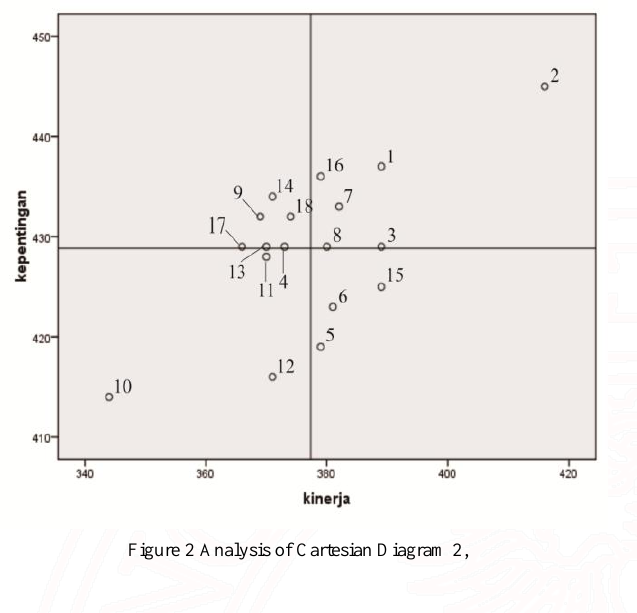
2. Level of Customer Satisfaction at Surya Mart Supermarket Ponorogo,